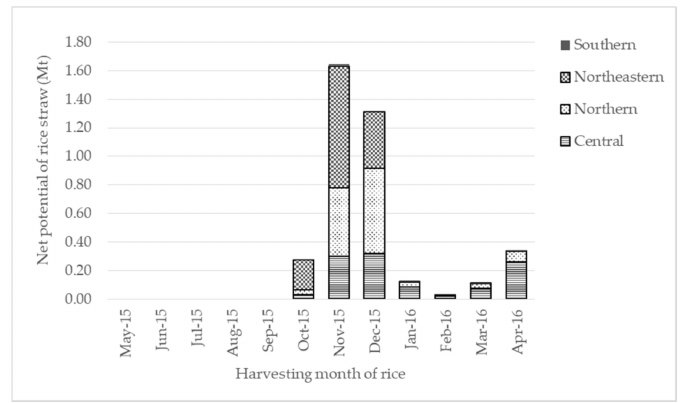
Figure 9. Monthly temporal distribution of the net potential of rice straw residue categorized by region.